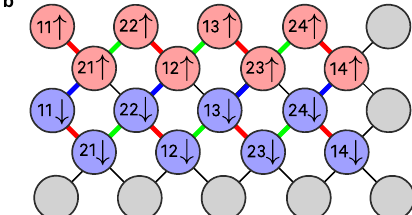
Fig. 2 | Qubit layout for implementing two Fermi-Hubbard instances. ( a ) 1×8 instance, ( b ) 2×4 instance. In each case two qubits are used to encode each site. Operationsbetweenqubitsinvariationallayersoccurinthefollowingpattern.1×8: blue (FSWAP), red (onsite), blue (FSWAP), red (vert1), green (vert2). 2×4: blue